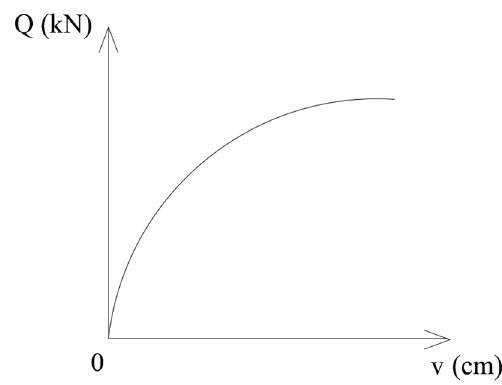
Figure 7. Shear-deformation relationship.